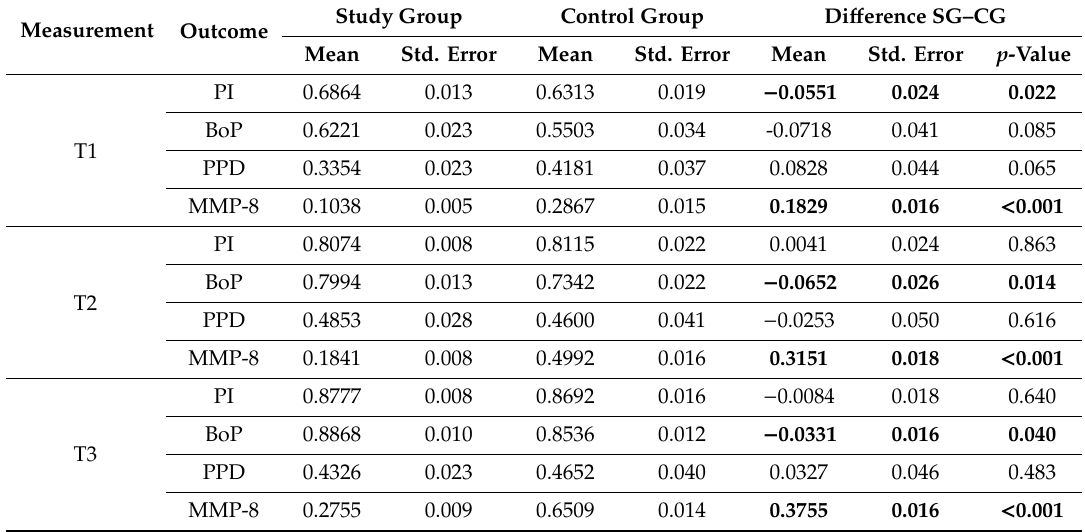
Table 2. Comparison of relative decreases of MMP-8 values and indices in the study group and control